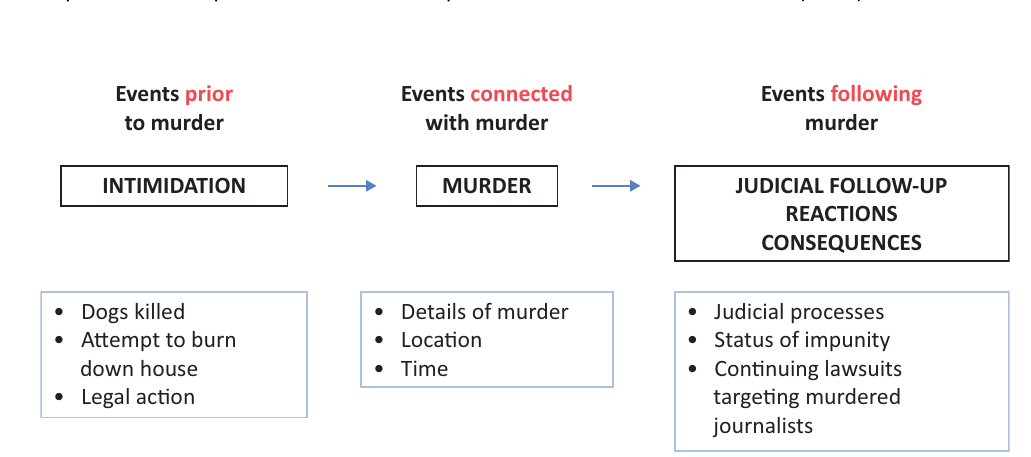
Figure 1. Excerpt from BBC report of the death of Daphne Caruana Galizia. Source: BBC (2018).